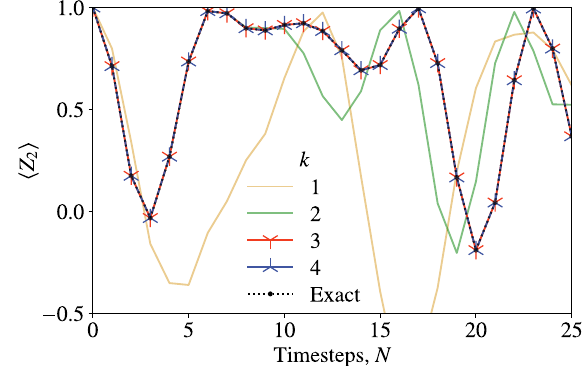
Fig. 7 Observable Convergence for Increasing Training States. The 5 qubit XY Hamiltonian is trained on an increasing number of training states, for the initial state ψ 0 j i ¼ 10000 j i . For each instance, C fsVFF was trained down to 10 − 10 on k training states, then the fsVFF ansätze V ( N Δ t ) k = WD ( N γ ) W † were used to fast-forward the initial state. For the Pauli operator Z 2 , we plot the expectation value of each fast-forwarded state. For k ⩾ 3 the expectation exactly reproduces the value produced by iterated Trotter evolved state, shown by the black dotted